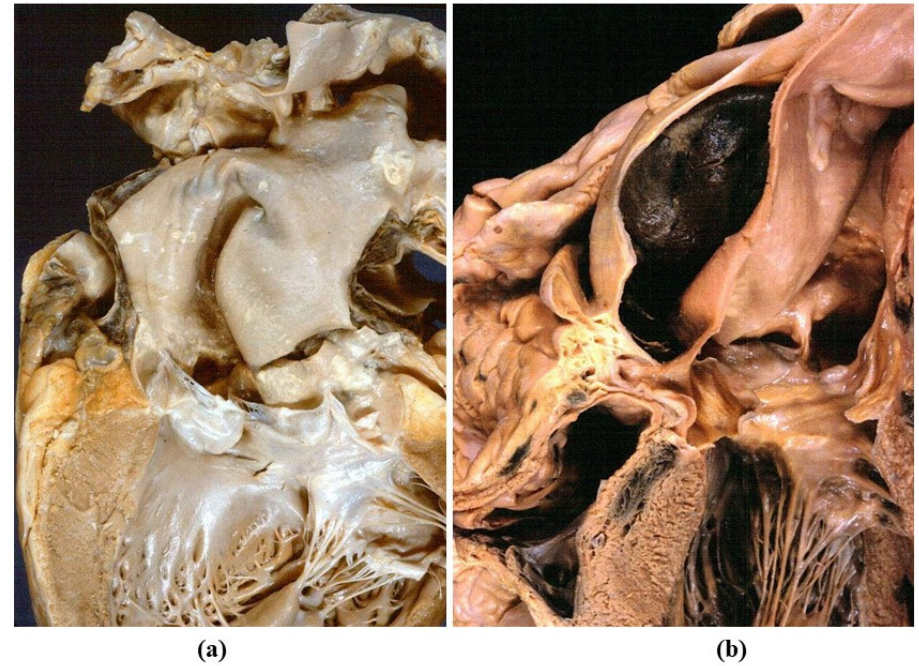
Figure 18. Aortic dissection with intimal tear ( a ) and dissection of the ascending aorta ( b ).